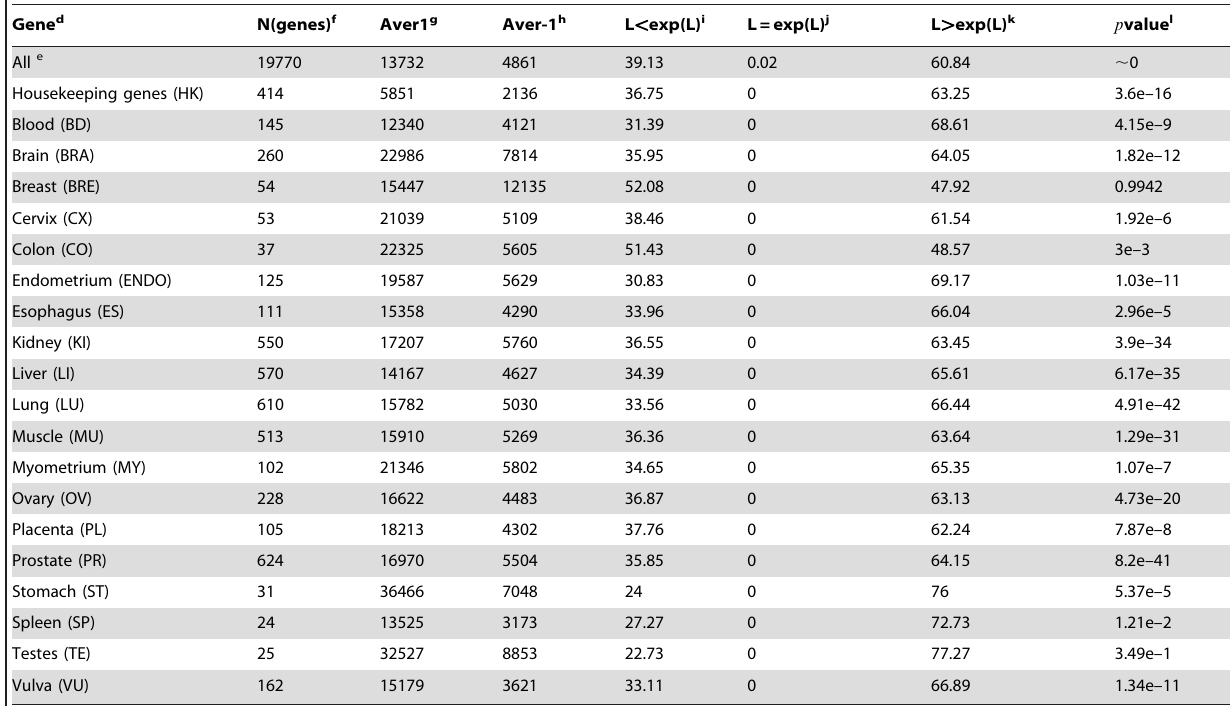
Table 1. Comparison of intron